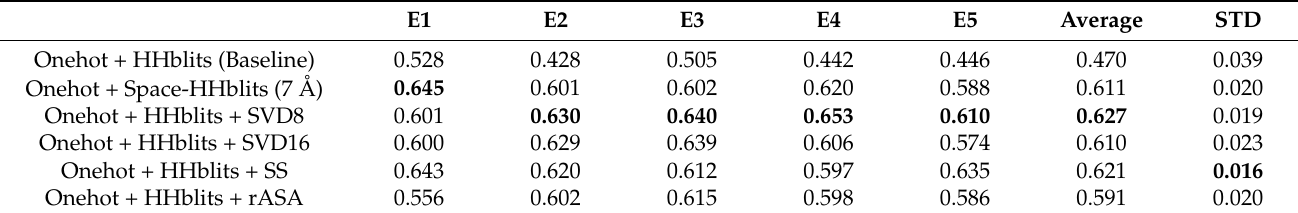
Table 4. Evaluation of features on membrane protein-metal binding site